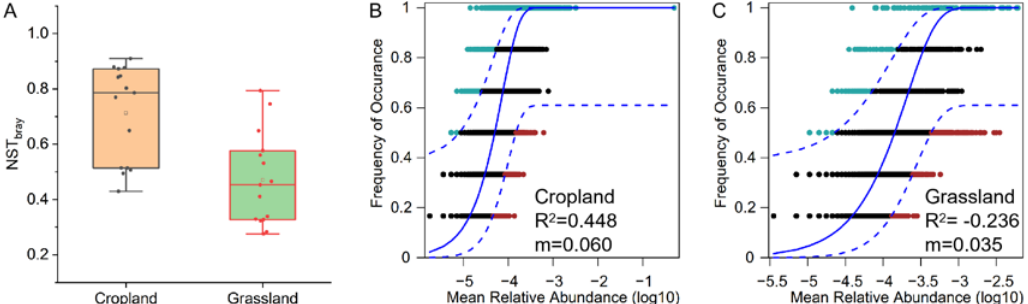
Figure 5. Assembly processes of bacterial communities in cropland and grassland soil from an agro-pastoral ecotone of Tibet. ( A ) Normalized stochasticity ratio (NST) of bacterial communities in cropland and grassland. A neutral community model was used to determine the contribution of stochastic processes to microbial community assembly in cropland ( B ) and grassland ( C ). In the model, “m” is the estimated migration rate, and the higher the value of “m”, the lower the degree of diffusion limitation of the bacterial community.